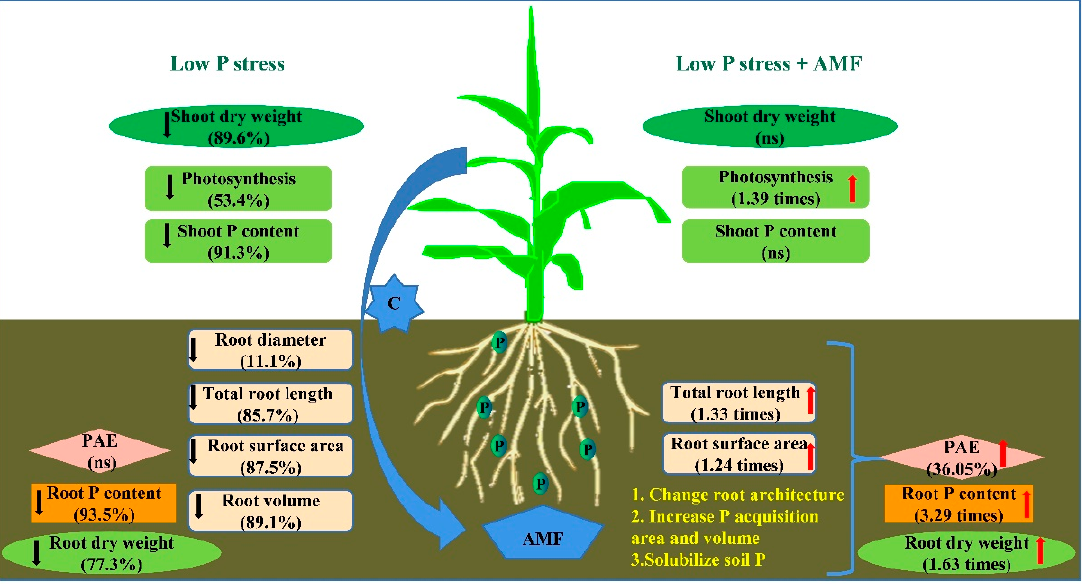
Figure 7. The role of arbuscular mycorrhizal (AM) fungi in improving plant growth, physiology, and alleviation of low P stress in maize. Note: Data for each trait under low P stress were compared to optimal P treatment (CK). Data for each trait under low P stress + AMF were compared to low P treatment (LP) on the respective trait of genotype Zhongke 11 as an example, respectively. Arrows indicate significant increase (in red) or decrease (in black) ns, non-significant effect.